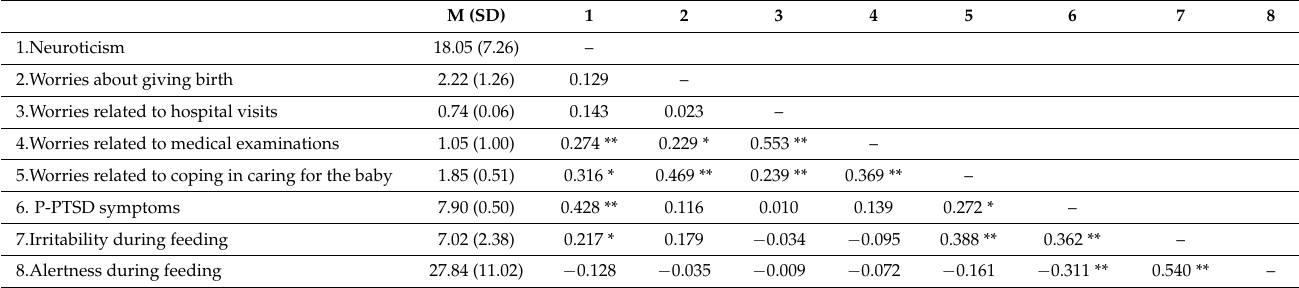
Table 2. Descriptive statistics and bivariate